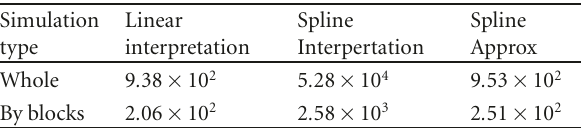
Table 5: Computational complexity comparison of simulations based on approximations—number of operations.